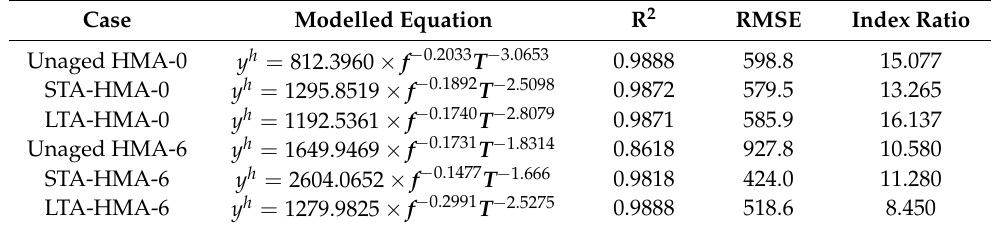
Table 5. Modelling